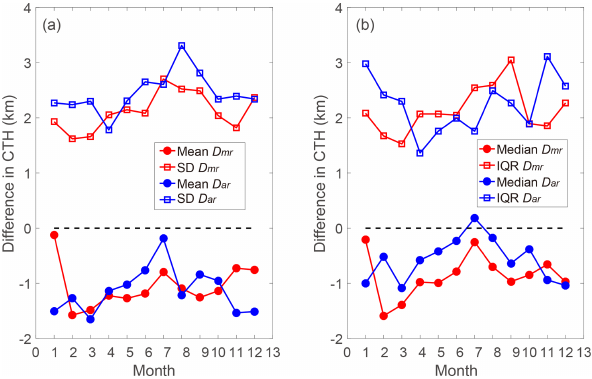
Figure 12. Monthly variations in (a) the mean and standard devi- ation of the D mr and the D ar , and (b) the median and IQR of the D mr and the D ar